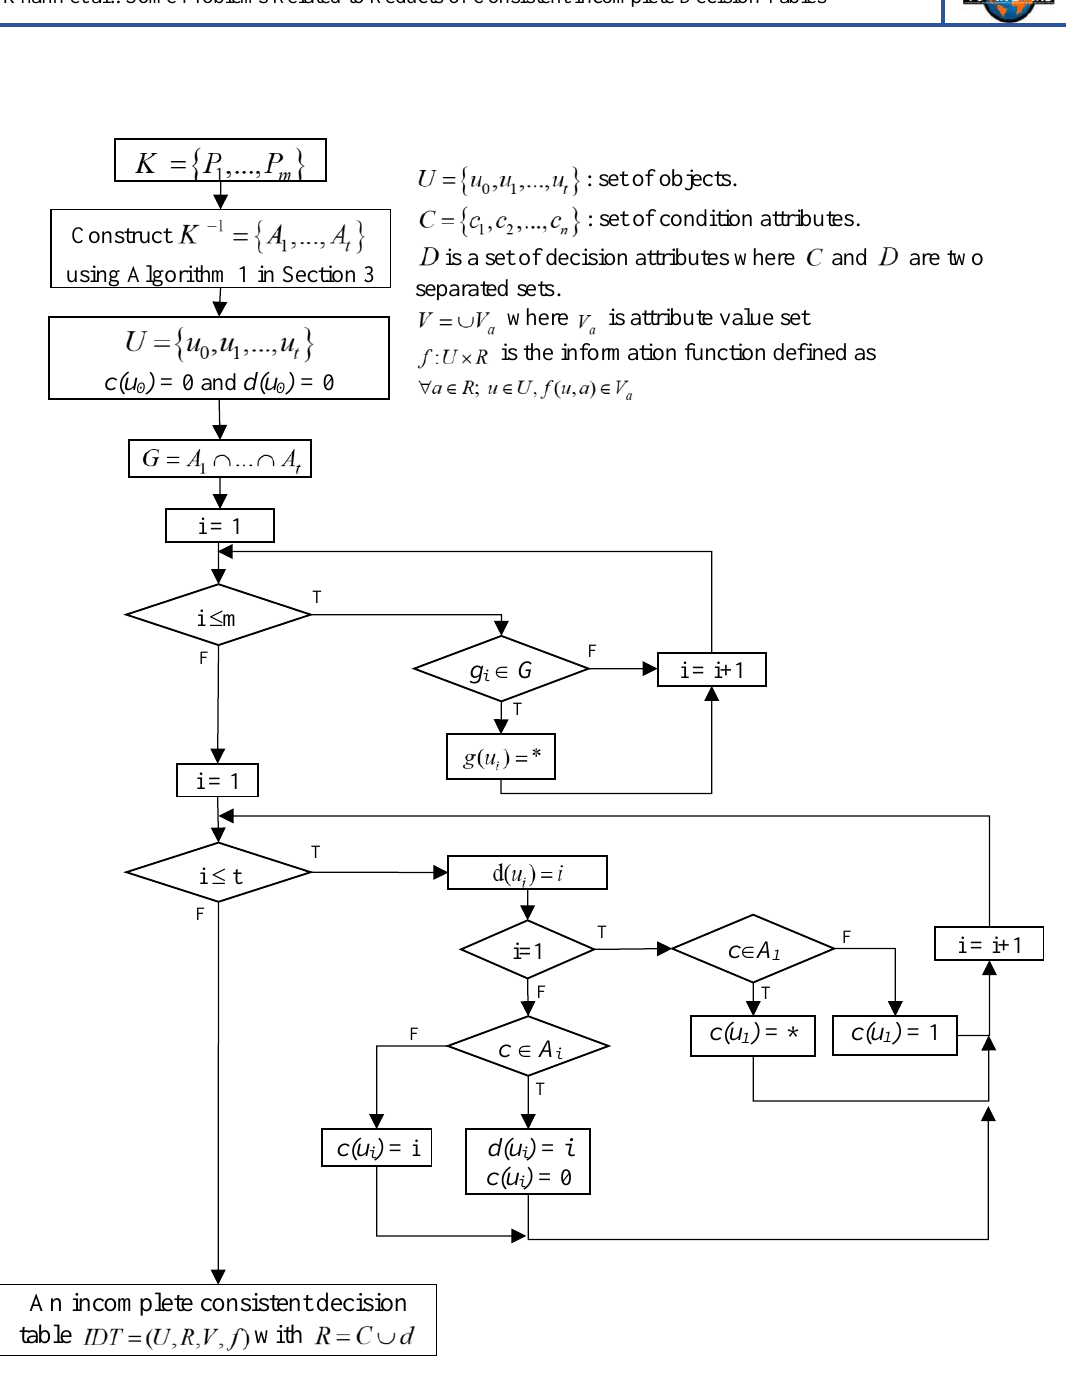
Figure 1. Flowchart of Algorithm